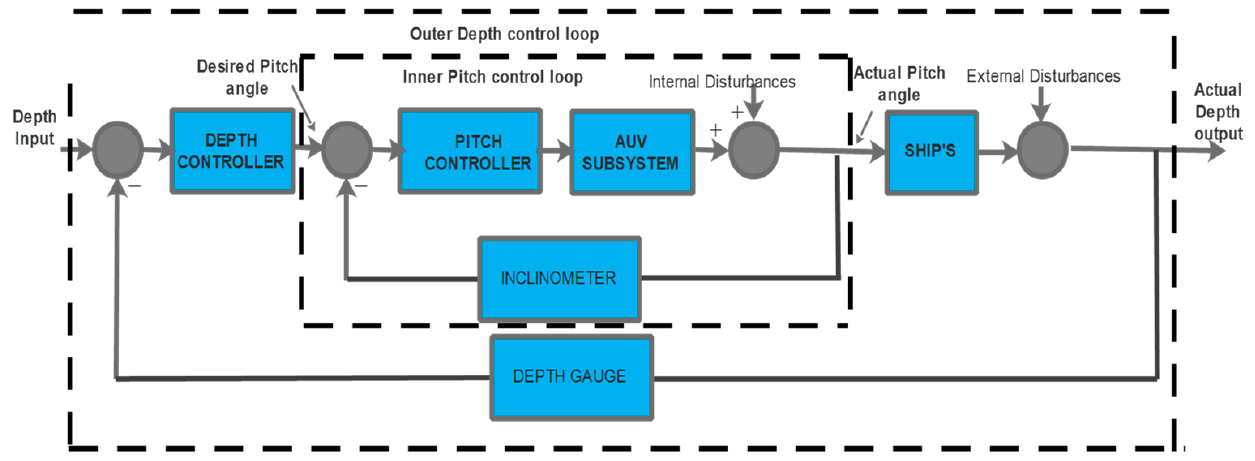
Figure 5. Block diagram of autonomous underwater vehicle’s depth plane control. The individual components of depth plane motion of the autonomous underwater vehicle are simpli fi ed [3] in Equation (34).